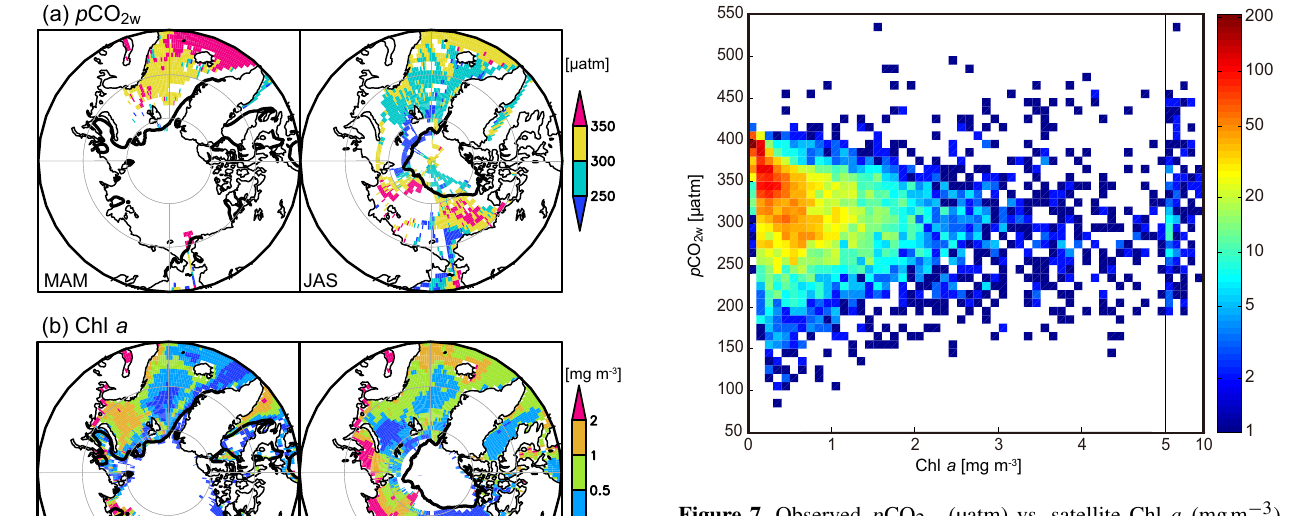
Figure 7. Observed p CO 2w (µatm) vs. satellite Chl a (mgm − 3 ) in the Arctic Ocean and its adjacent seas (north of 60 ◦ N) from 1997 to 2014. Colors indicate the number of data pairs in a 0.1mgm − 3 × 5µatm bin when Chl a ≤ 5mgm − 3 , or in a 1mgm − 3 × 5µatm bin when Chl a > 5mgm − 3